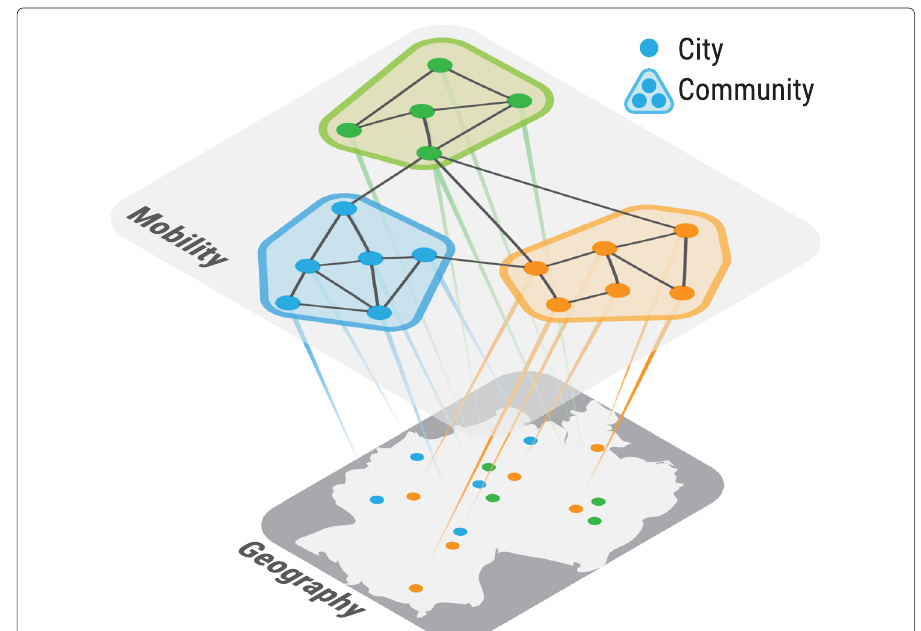
Fig. 4 To test that intercity mobility is marked by national borders we extract the communities from the mobility network (upper layer) and compare them with the geographical boundaries of the countries these cities are located